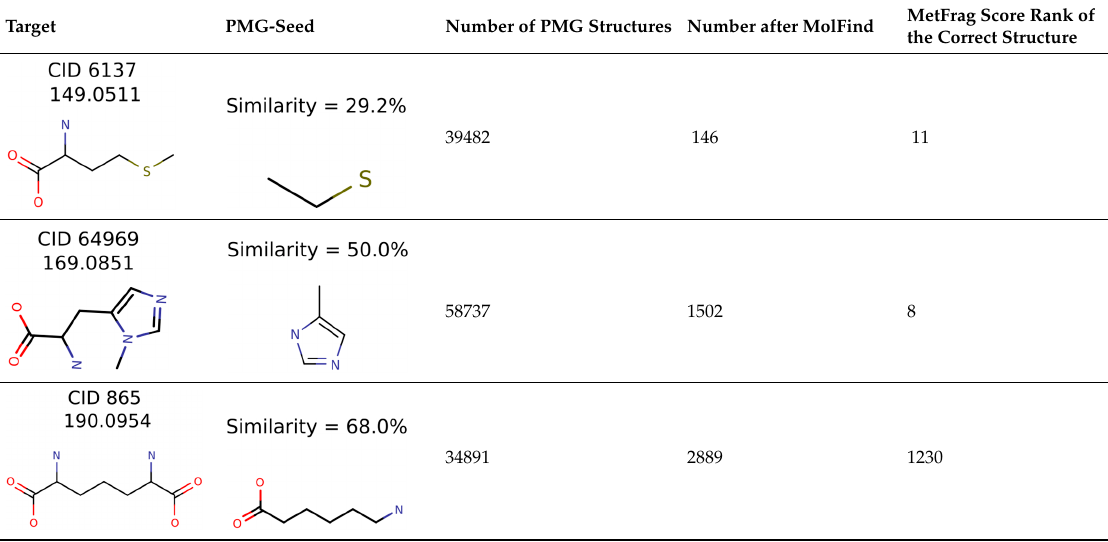
Table 2. Putative unknowns identified with Algorithm-1.